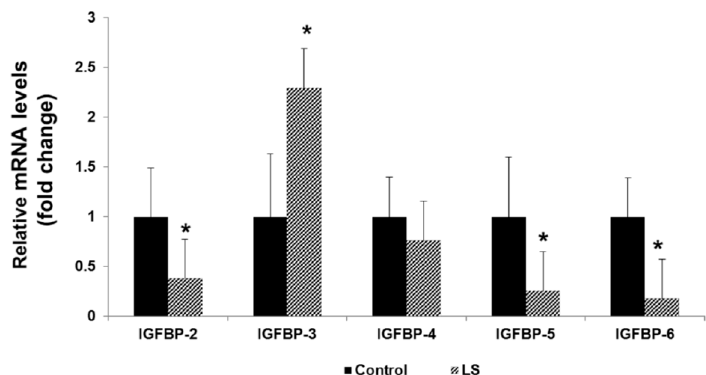
Figure 6. Expression of IGF-binding protein (IGFBP) mRNA in Laron syndrome. Total RNA was prepared from lymphoblastoid cell lines derived from four LS patients (gray bars) and four controls (closed bars) of the same age range, gender, and ethnic origin. Levels of IGFBP-2, -3, -4, -5, and -6 mRNAs were measured by RQ-PCR. For each IGFBP mRNA, a value of 1 was given to the level displayed by controls. Bars denote mean ± SD ( n = 4). Legend: *, p < 0.05 versus respective control. Results indicate that mRNA levels of IGFBPs usually regarded as pro-mitogenic (IGFBP-2, -5, and -6) were reduced in LS, whereas IGFBP-3 (a pro-apoptotic protein) levels were increased under this condition. The figure was adapted from [71].